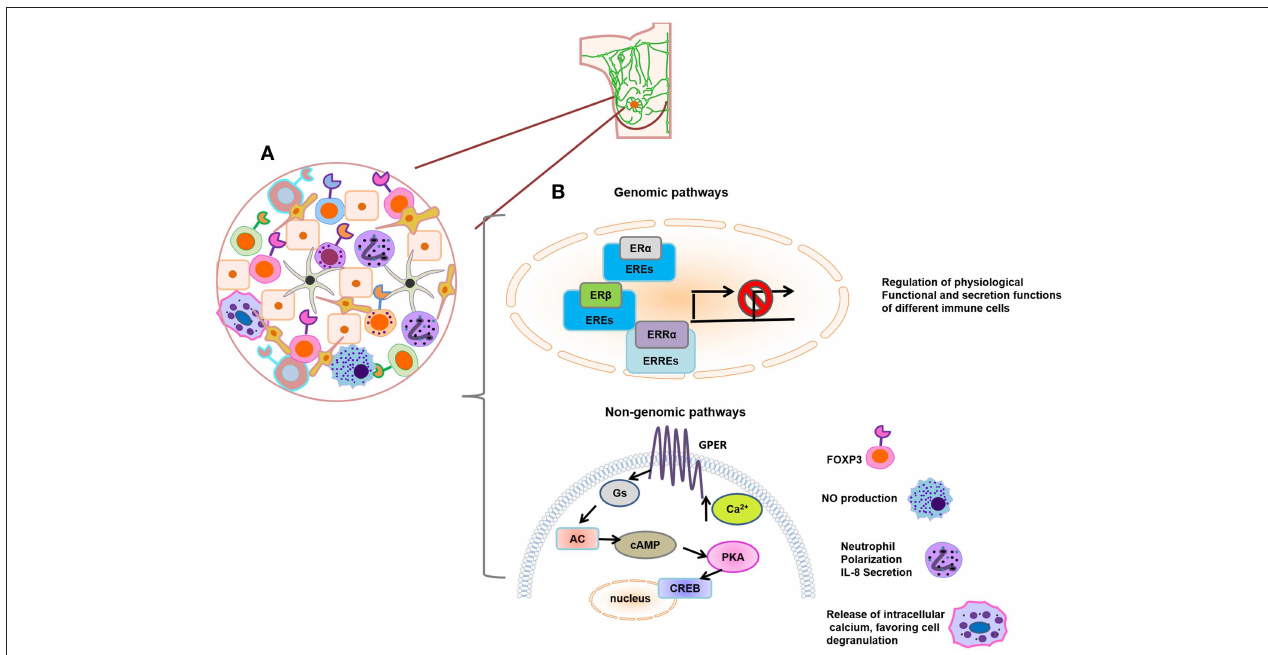
FIGURE 3 | (A) Schematic representation of immune infiltrating tumor cells. (B) Genomic and non-genomic estrogen pathways on immune cells. Estrogen regulates the physiological, functional, and secretion actions of different immune cells; these effects are mainly studied by the activation of genomic pathways such as ER α , ER β , or ERR α . In addition, little effects of Tregs (increase of Foxp3 expression), macrophages (NO production), neutrophils (neutrophil polarization and IL-8 secretion), and mast cells (mobilization of intracellular calcium, favoring cell degranulation) have been described by the action of non-genomic